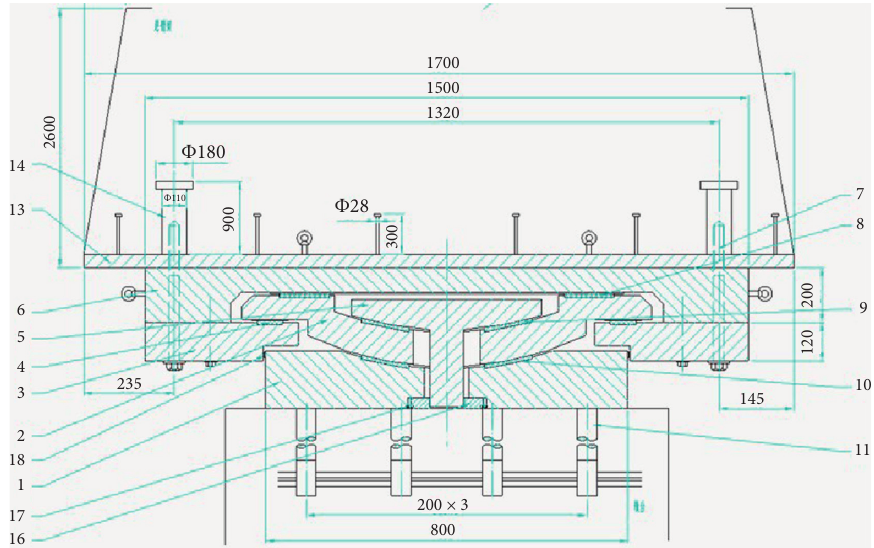
Figure 3: Details of the bearing (unit: